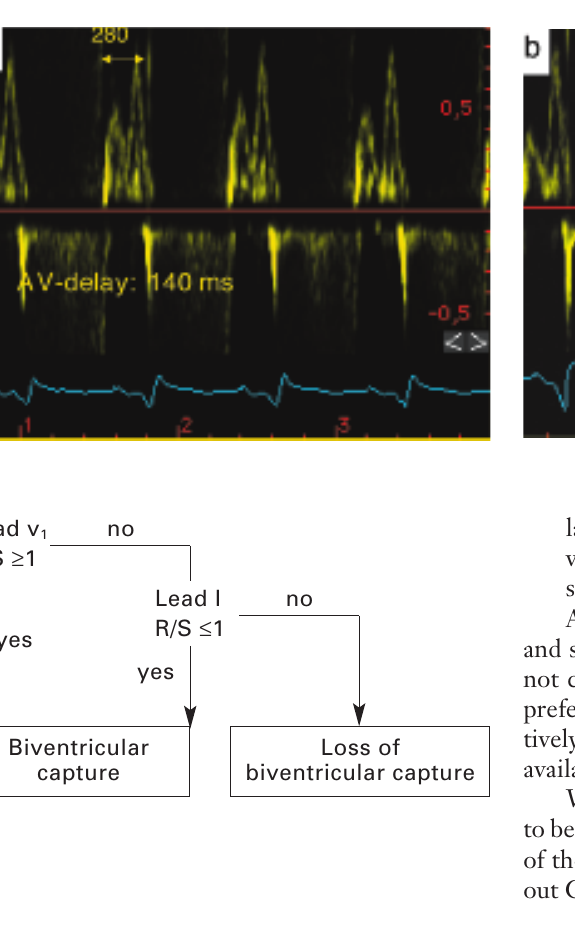
Figure 3 a, b: Lengthening of the diastolic left ven- tricular filling time by shortening of the AV-interval measured by Doppler echocar- diography of the mitral inflow.